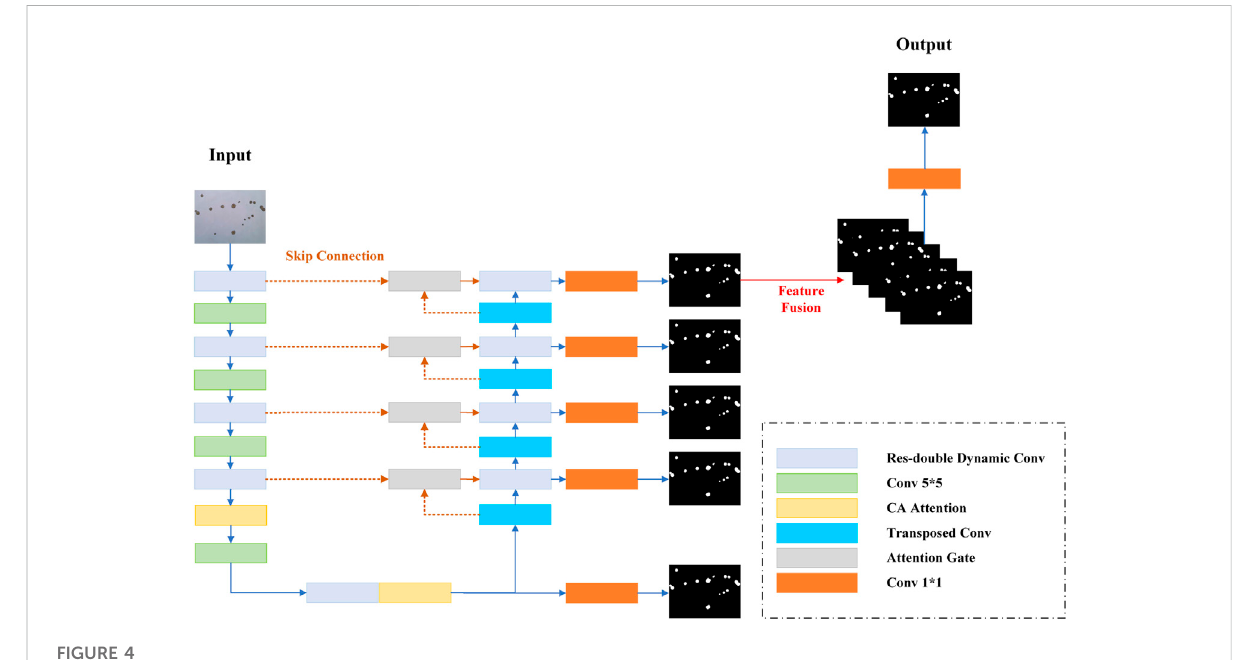
FIGURE 4 Schematic of the RADU-Net model